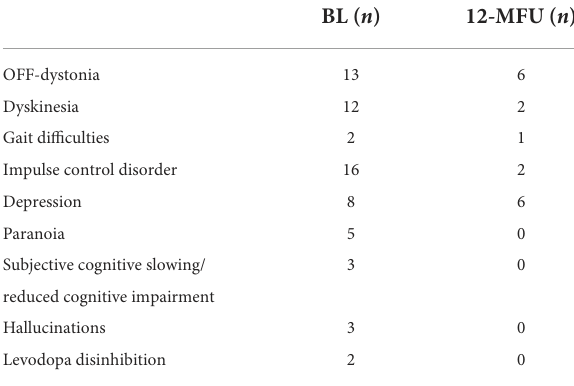
TABLE 3 Additional motor and/or neuropsychiatric patient complaints and symptoms apart from bradykinetic-rigid syndrome or tremor in the EOPD cohort at baseline (BL) and after 12 months of DBS